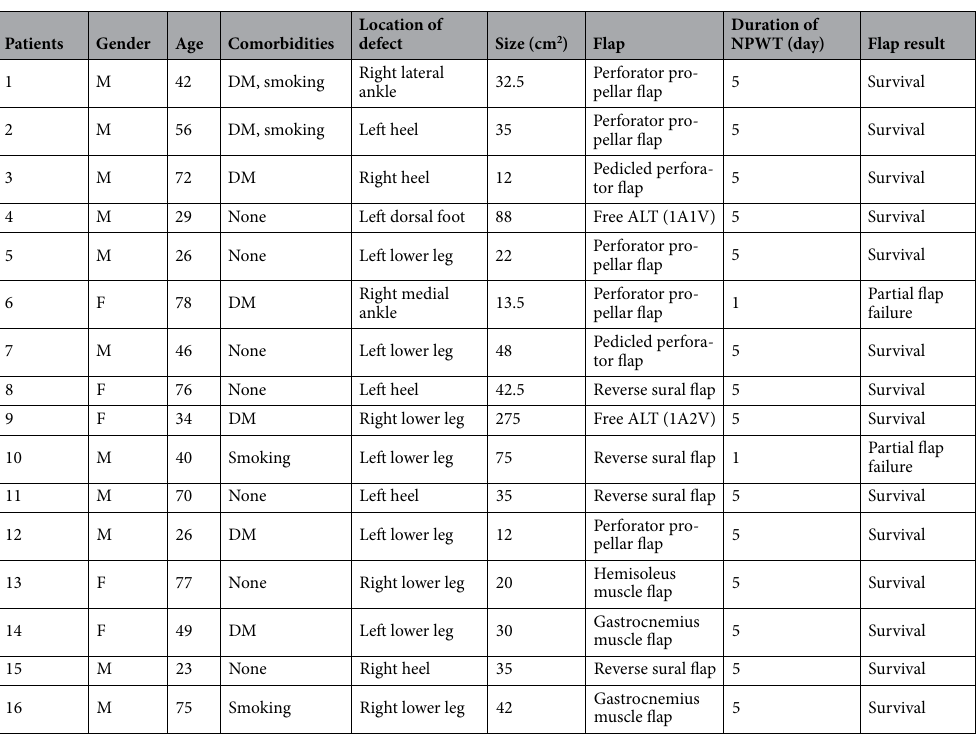
Table 1. Patient characteristics and results. ALT anterolateral thigh, DM diabetes mellitus, NPWT negative pressure wound therapy, A anastomosed artery, V anastomosed vein.